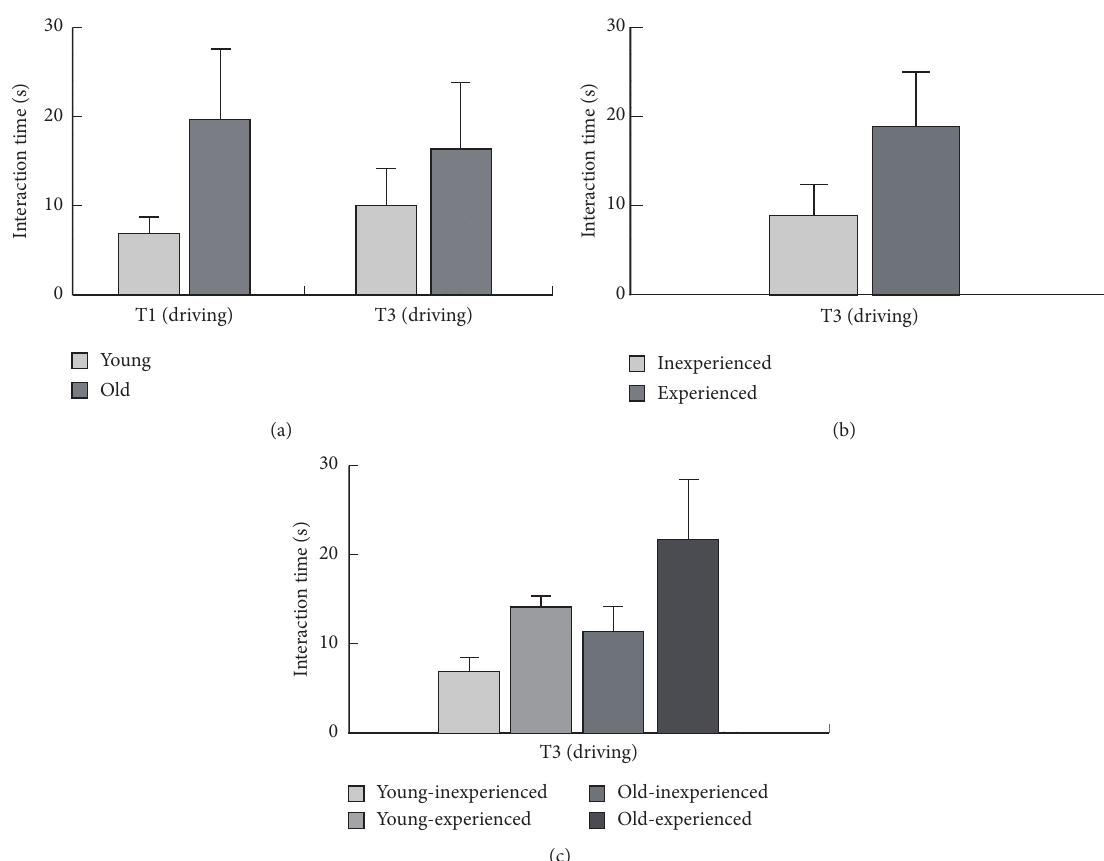
Figure 3: Interaction time results: (a) the interaction time of old and young drivers. (b) The interaction time of experienced vs. inex- perienced drivers and (c) the interaction time of all four groups).